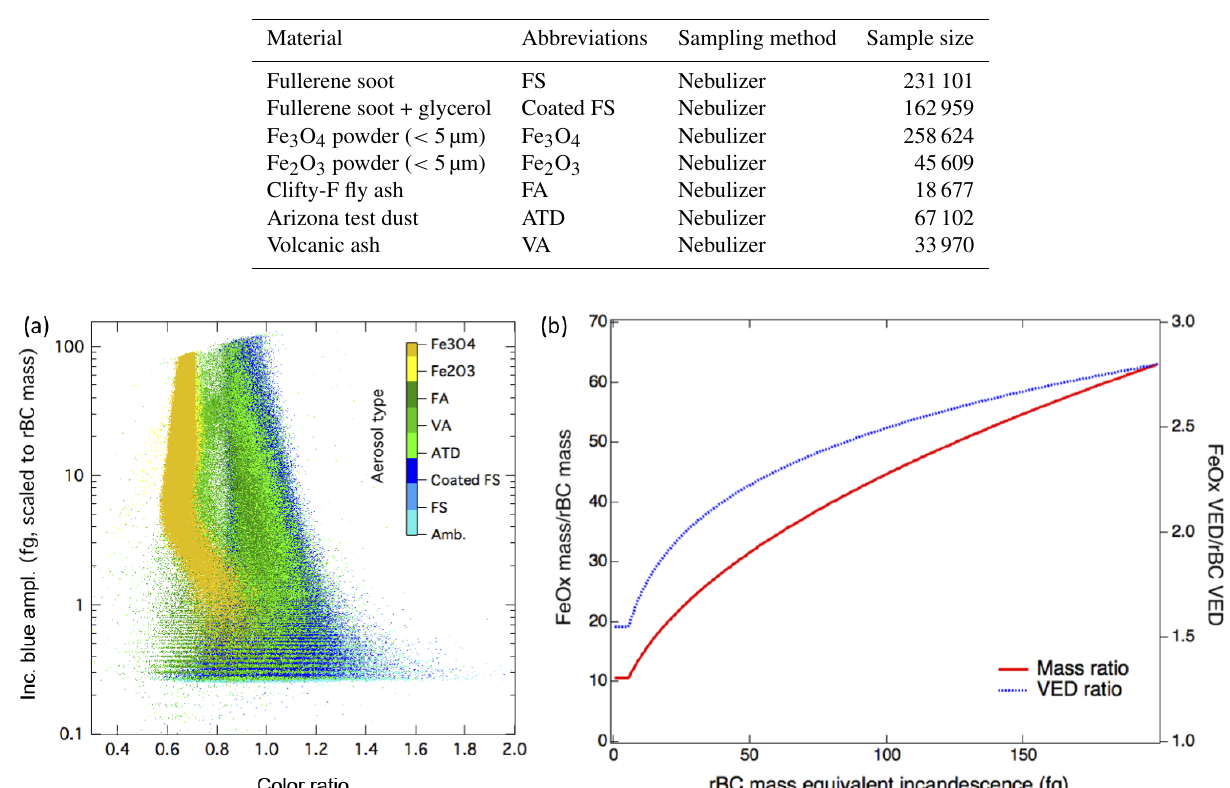
Figure 2. (a) Incandescent-peak-height-to-color-ratio relationship for different incandescent aerosol types. Laboratory samples of different test materials show significant overlap between incandescent peak height and color ratio. Each point represents a single particle, and the abbreviations are given in Table 1, with Amb. indicating ambient particles. (b) Comparison of FeO x and rBC detection in the SP2. Relative mass and volume equivalent diameter (VED) for rBC and FeO x observed by the SP2. Because of the power law relationship for the mass to incandescent signals of FeO x , the largest particles detected by the SP2 are approximately 60 × more massive than rBC with the same incandescent signal. FeO x is significantly denser than rBC, however; the volume equivalent diameter ratio is less than a factor of 3 for particles within the SP2 detection range. Inc. refers to incandescent in the